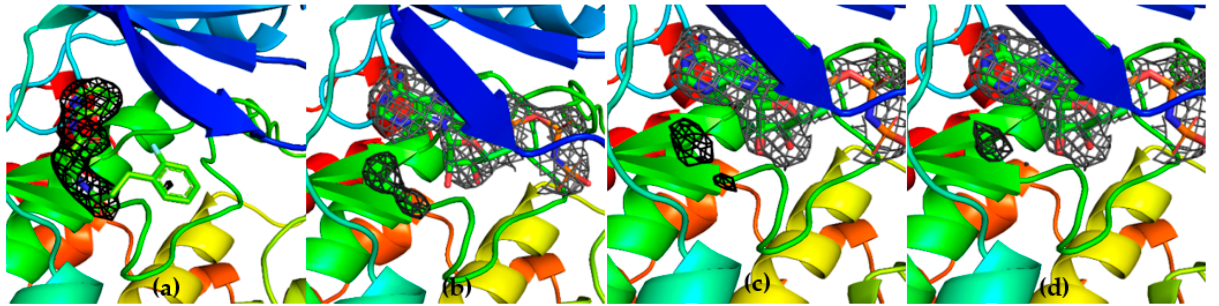
Figure 10. Three-dimensional structures GSK-3 β in complex with G12 in the presence of increasing concentrations of AMP-PNP (0 mM AMP-PNP ( a ); 1 mM AMP-PNP ( b ); 2 mM AMP-PNP ( c ); 4 mM AMP-PNP ( d )).